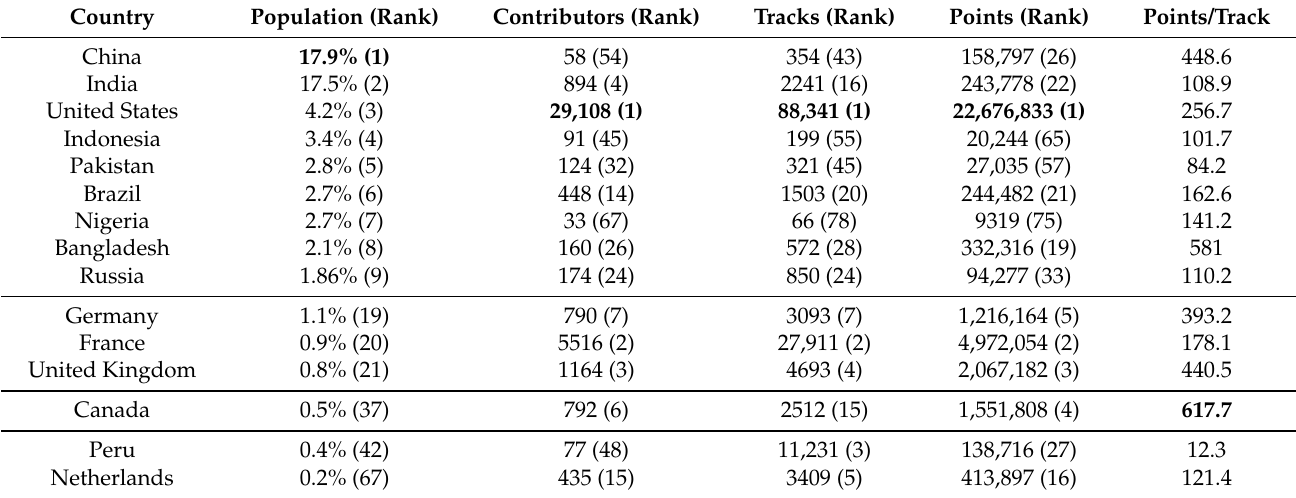
Table 10. Distribution of the collected data per country and ranking (first ranks are displayed in bold). Population per country (percentage of world population) data are from in